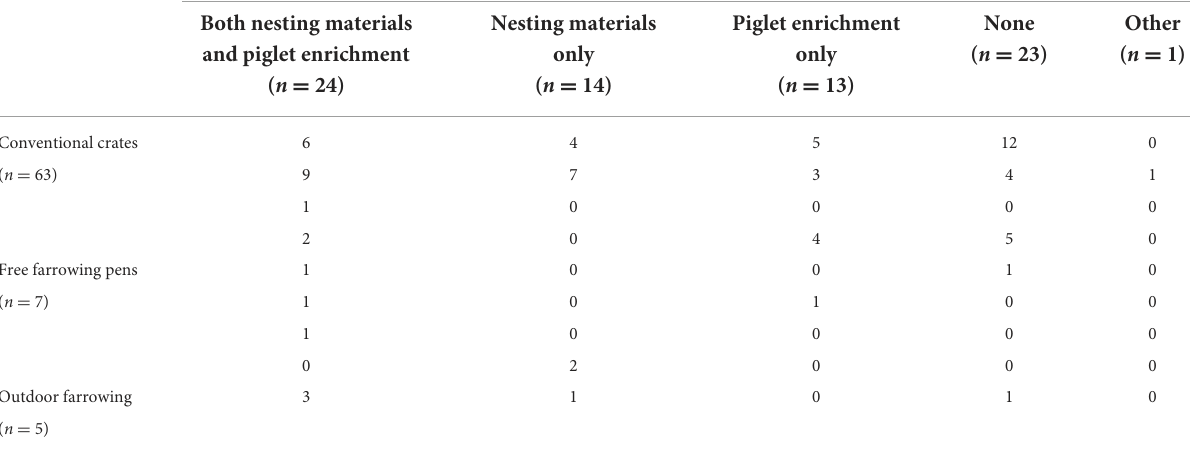
TABLE 8 Counts of use of enrichment by farrowing systems as reported by respondents.